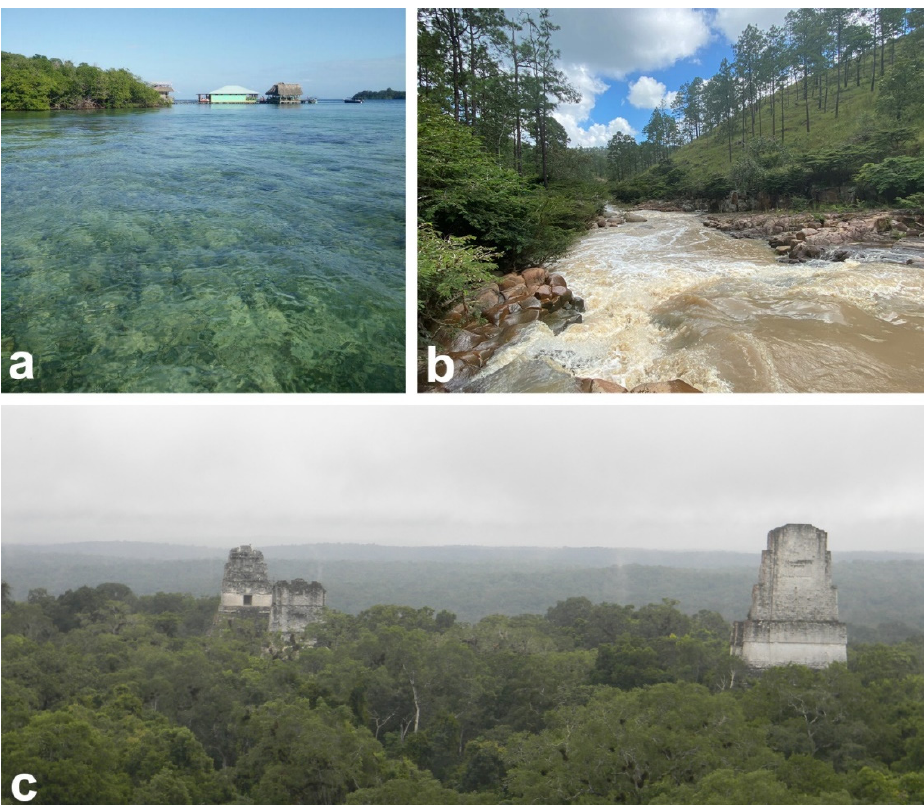
Figure 4. Geomorphic units of Central America.